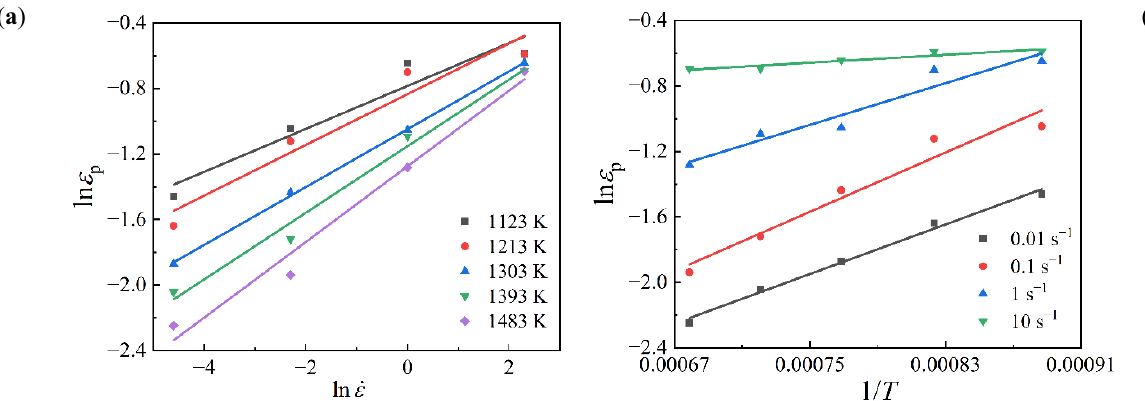
ln ε ~ ln ε  and ( b ) p